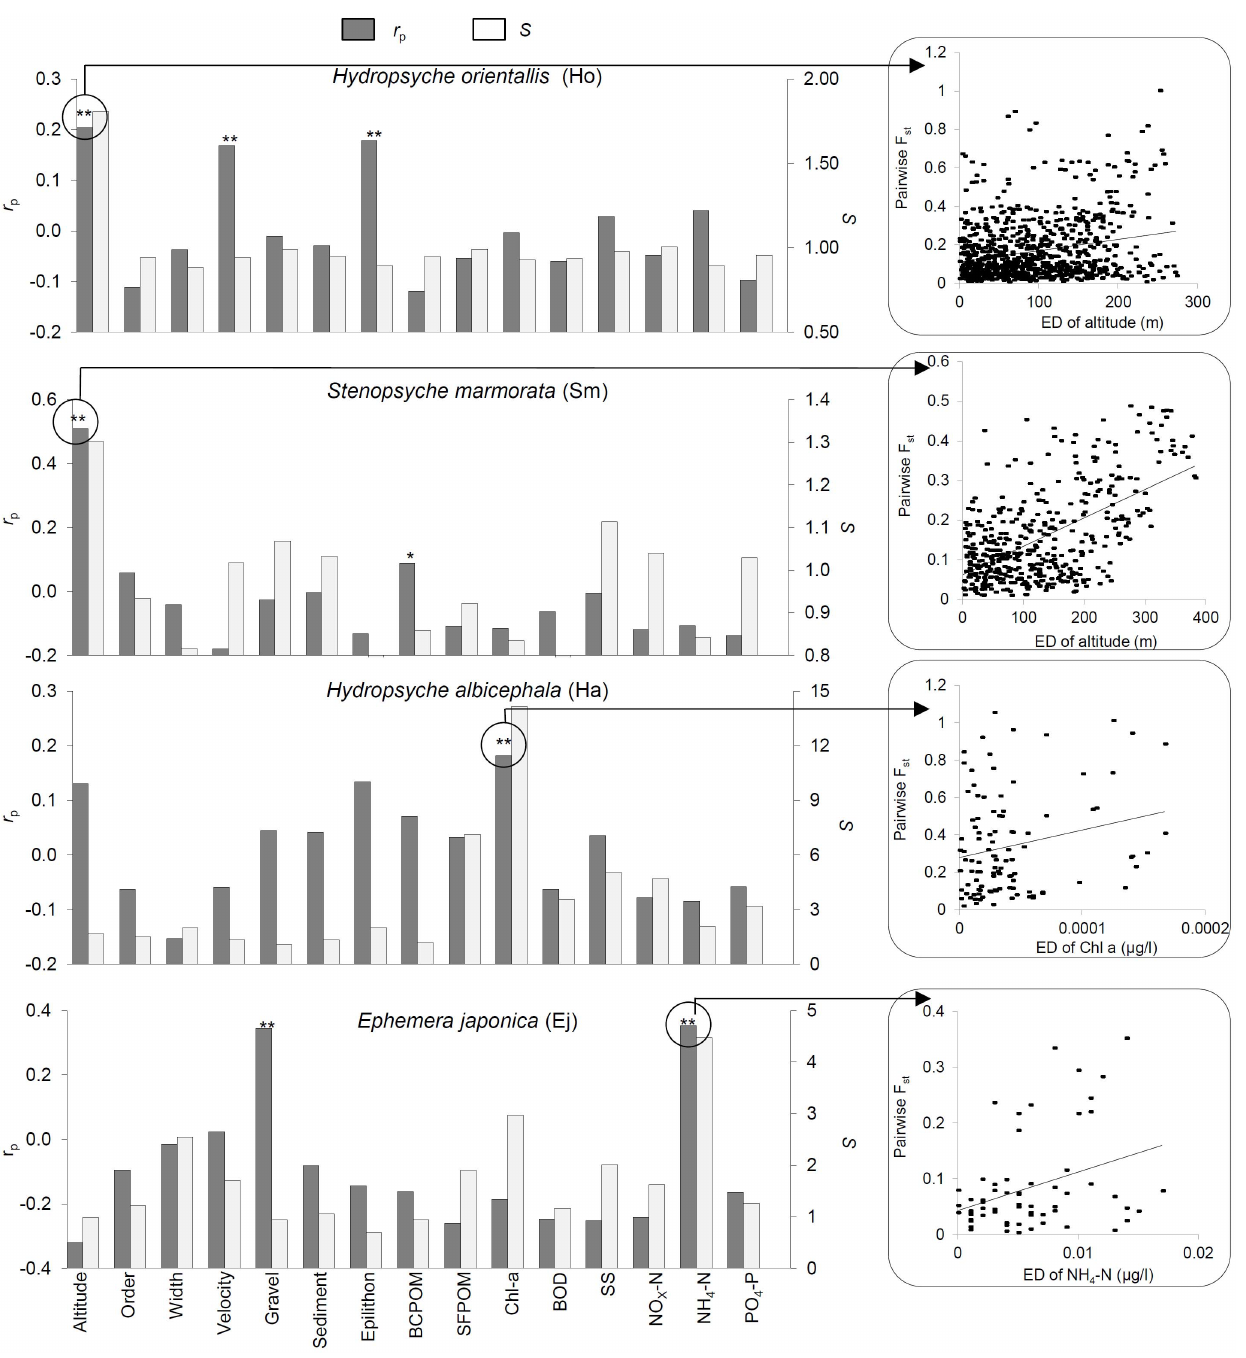
Figure 2. Specialization index (open bars) and genetic-environment correlation coefficients at outlier loci (filled bars) for each species and each environmental variable. Partial Mantel tests were used to calculate r p in order to control for any effect of geographic distance. **= significant partial Mantel correlation (p , 0.001, randomizations test). In each species, highest r p and highest S occurred with the same environmental variable. These were altitude (Ho, Sm), transported chlorophyll- a (Ha), and ammonium-nitrogen (Ej). Correlations with highest r p are shown in the right-hand panels. doi:10.1371/journal.pone.0093055.g002 scale of measurement. Altitude was most strongly correlated with insolation, primary production). Temperature is often an a priori non-neutral pairwise F st in two species (Ho and Sm). Altitude itself factor for which adaptation is tested (e.g., [17]) because of its is related to a number of resource and habitat variables in stream overwhelming influence on organismal physiology. In stream environments like those studied here, altitude is often strongly ecosystems, some of which were measured here (e.g., stream size, water velocity), and some of which were not measured (solar associated with mean annual water temperature, and the stronger